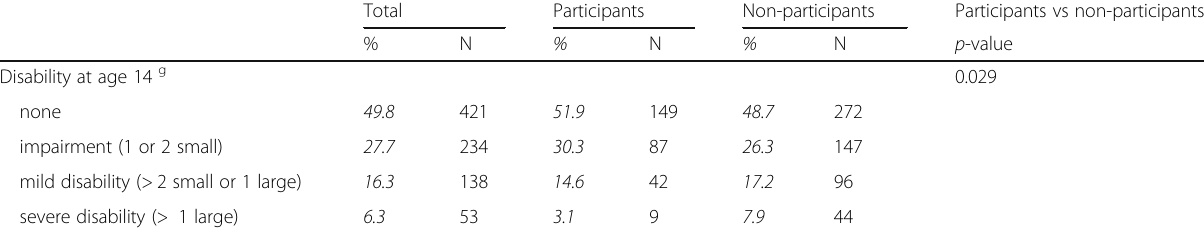
Table 1 Demographic and Neonatal characteristics: participants versus non-participants